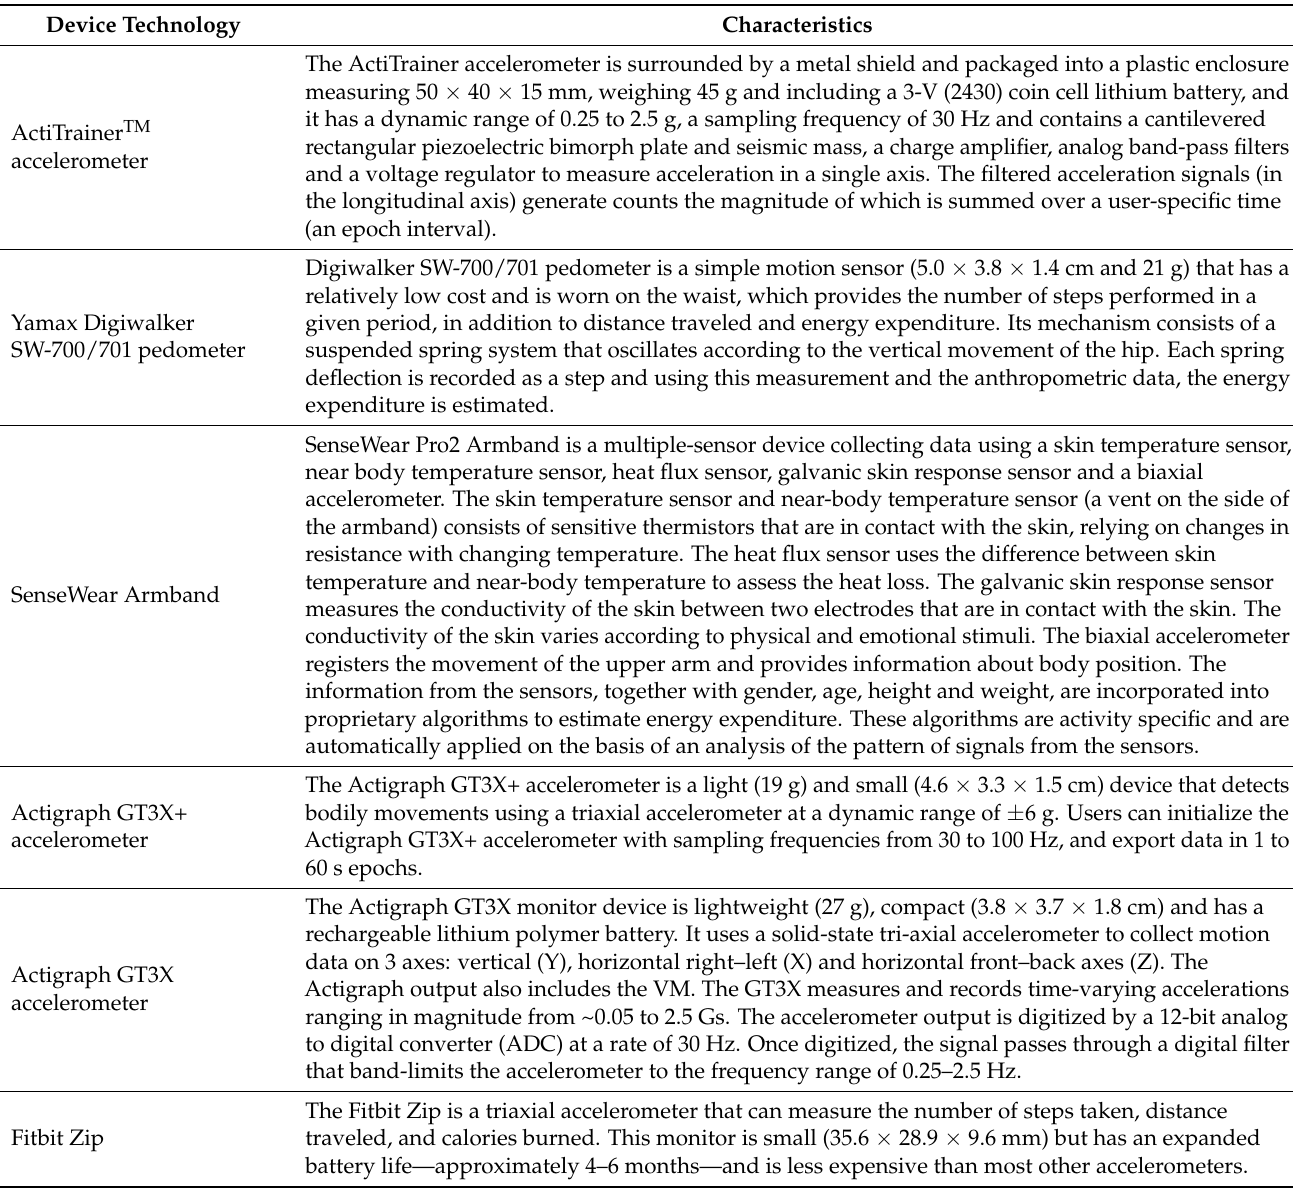
Table 2. Characteristics of the devices included in the